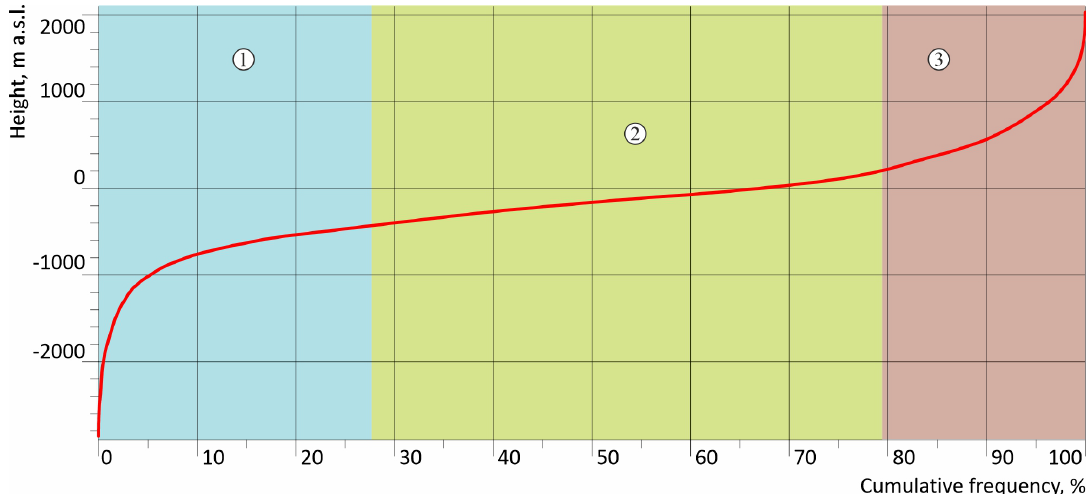
Figure 11. The hypsographic curve of the research area. 1—Deep-water basins and trenches; 2—lowlands; 3—hills and low